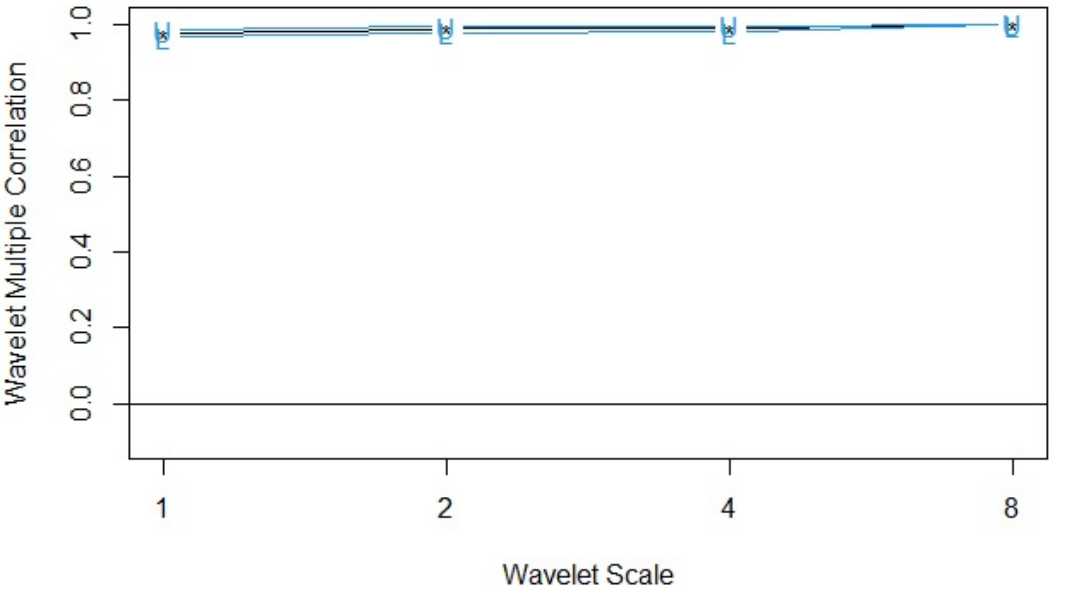
Figure 12. WMC among GSE, banking sector financial soundness, and interest rates. U—upper limits, L—lower (at 95% confidence interval), *—plots of actual WMC values. Table 6. WMC among GSE, banking sector financial soundness, and interest rates.